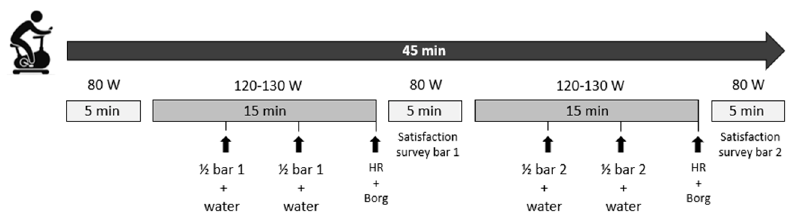
Figure 1. Protocol followed during the intervention. Abbreviations: W, Watts; HR, heart rate; Borg, perceived exertion using the Borg CR-10